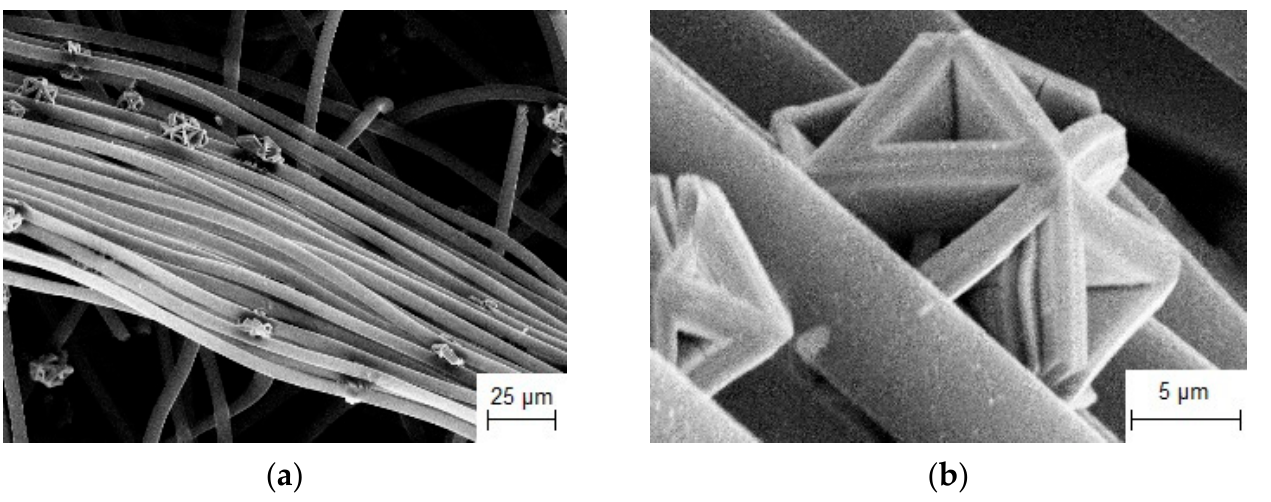
Figure 12. Micrographs of the molybdenum carbide-carbon fiber composite at different scale. ( a )— Overall view and ( b )—a single Mo 2 C crystal. Synthesis conditions: CT in NaCl-KCl-Na 2 MoO 4 (15 wt.%)–Mo melt at 1123 K and for 1 h.